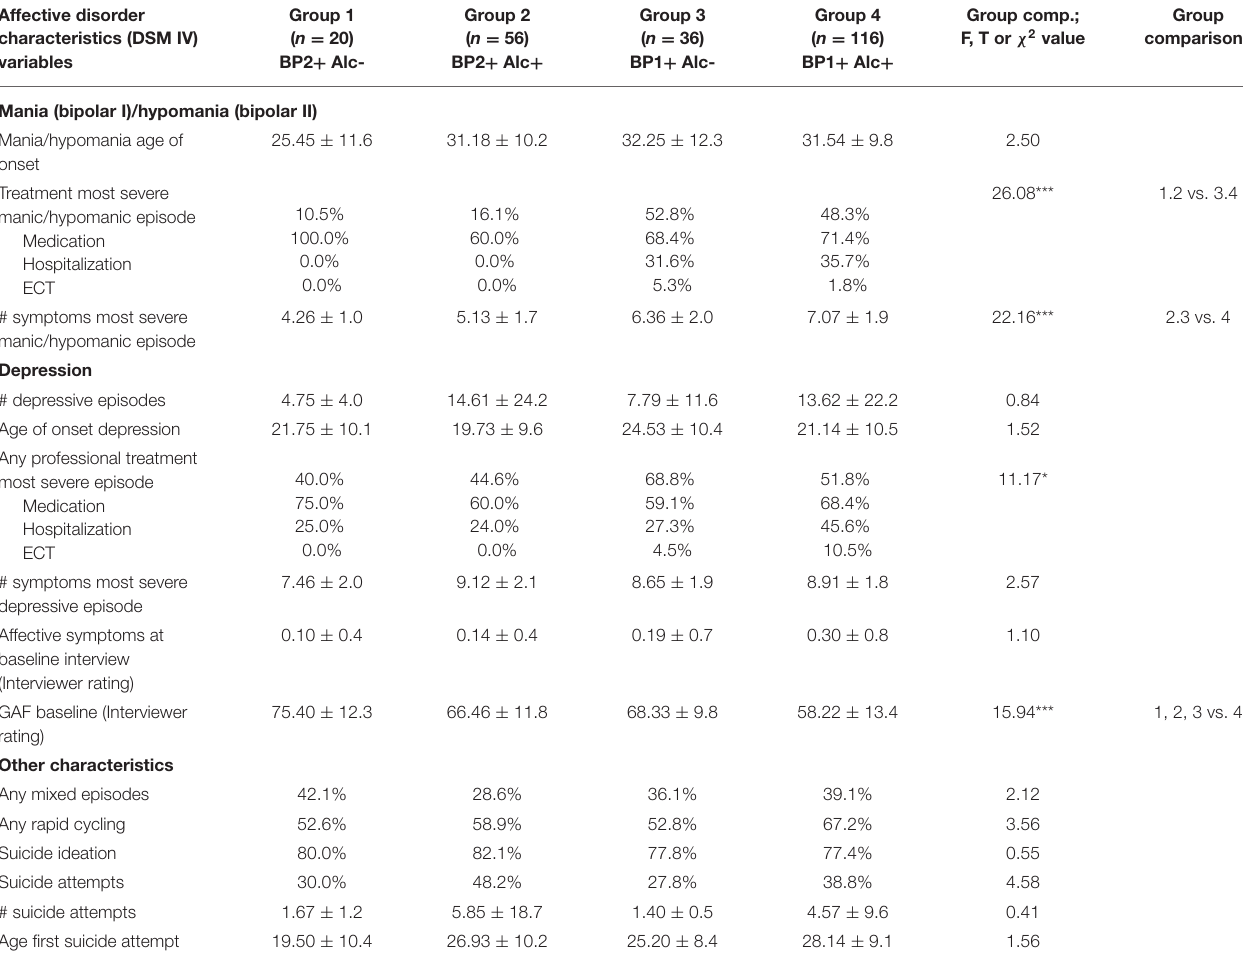
Group comp.; Group F, T or χ 2 value